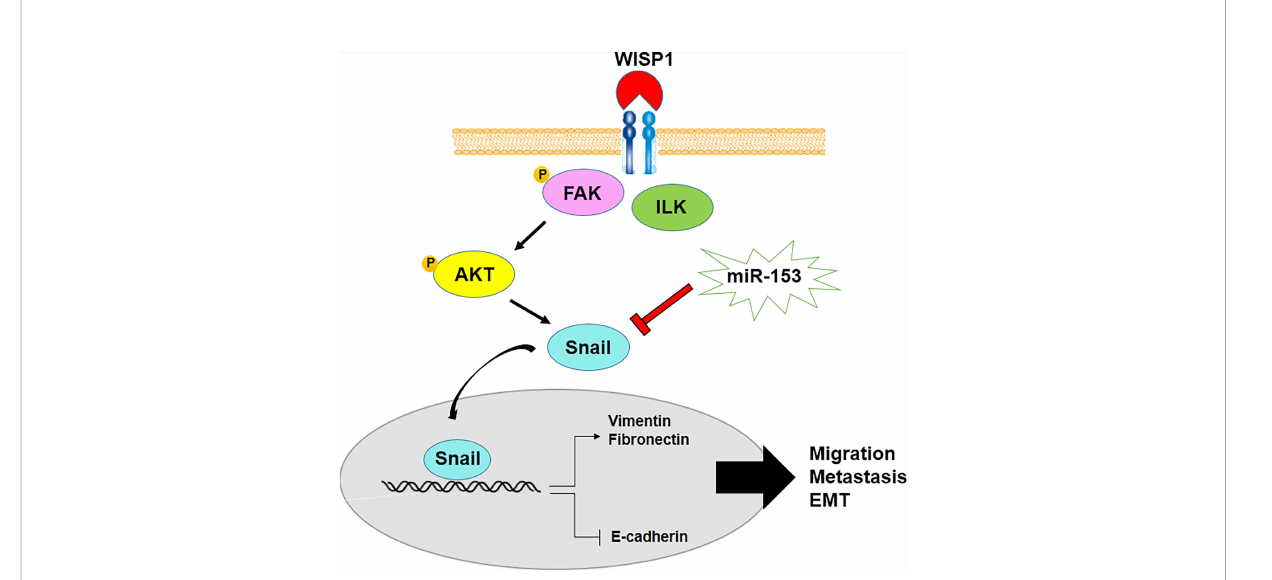
FIGURE 2 miR-153 regulates metastasis and EMT of cancer cells through decrease in E-cadherin and increase in expression levels of mesenchymal